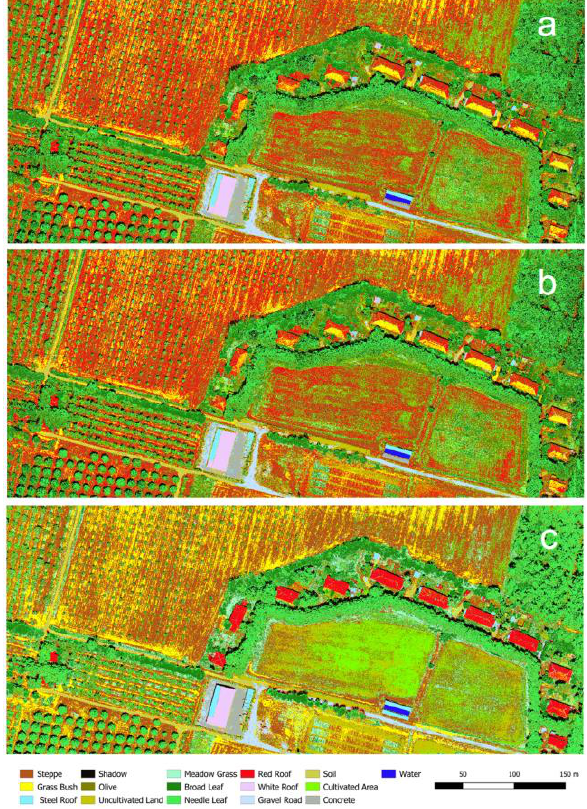
Figure 4. Classification maps of pixel-based